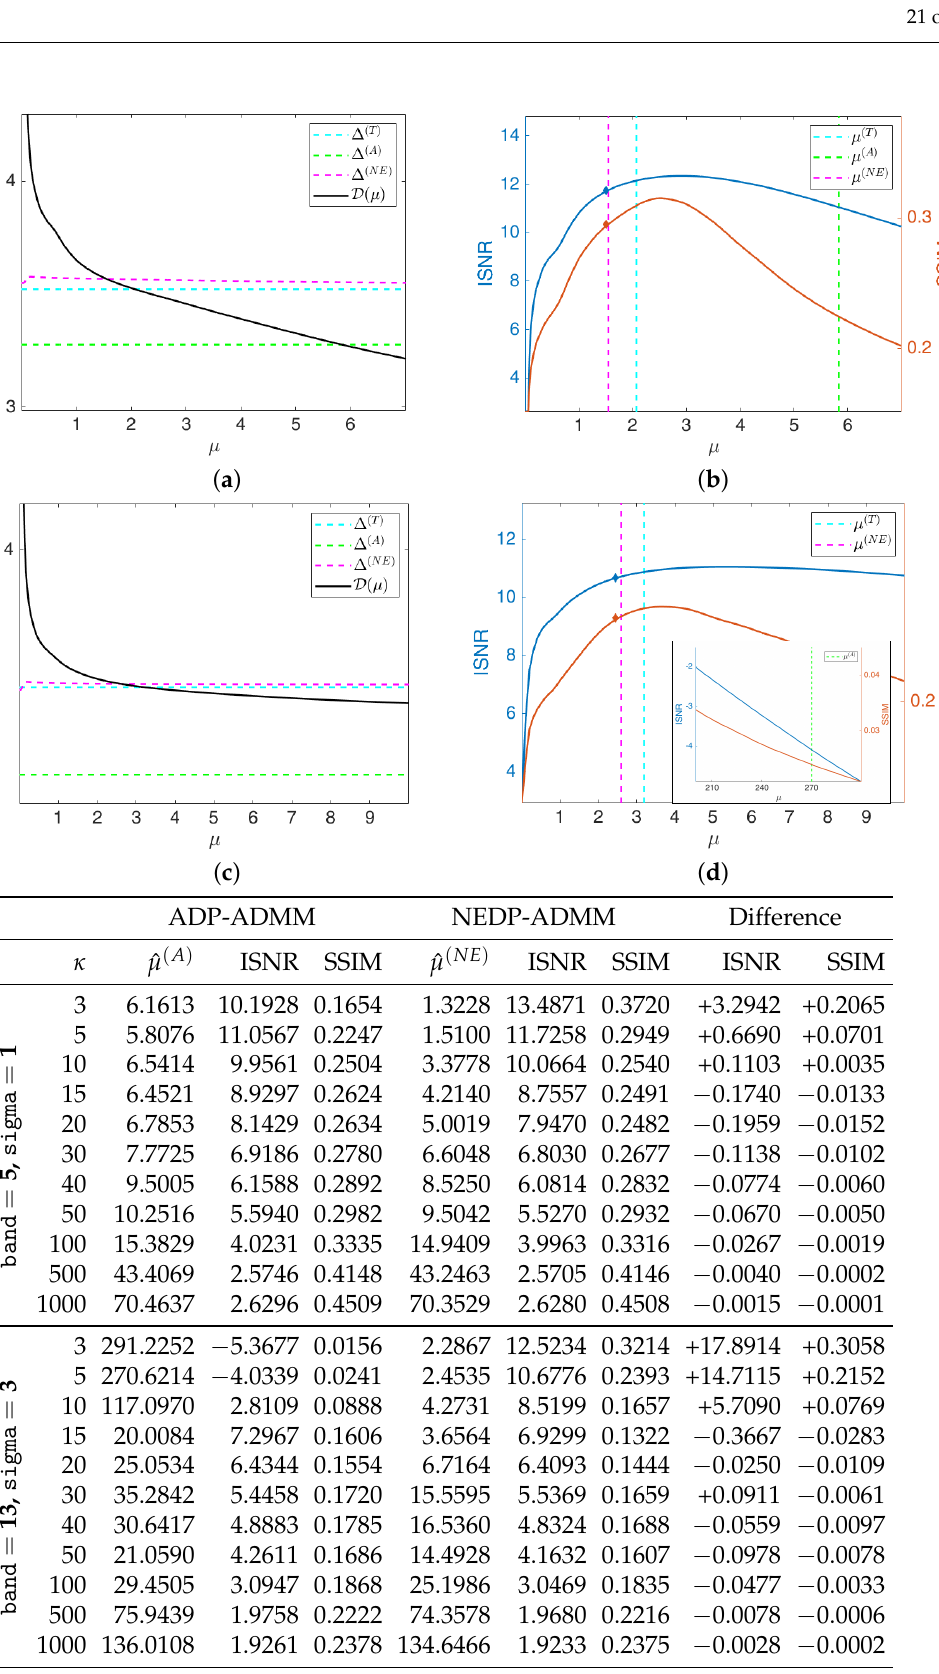
Figure 6. Test image cameraman . Top : discrepancy curve divided by 10 4 ( a , c ) and ISNR/SSIM values ( b , d ) achieved for different µ -values with κ = 5 and Gaussian blur with parameters band = 5, sigma = 1 ( first row) and band = 13, sigma = 3 ( second row). Bottom : output µ -values and ISNR/SSIM values obtained by the ADP-ADMM and the NEDP-ADMM for the two blur levels considered and different photon counts κ